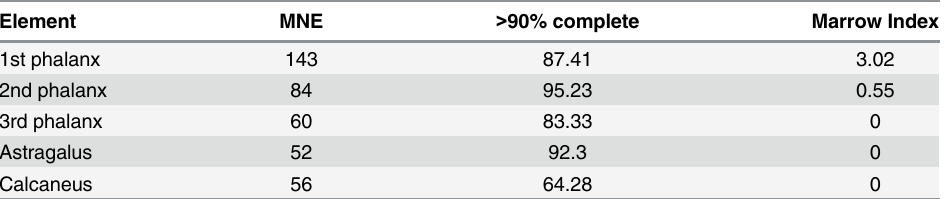
Table 4. MNE, element completeness and marrow index for gazelle foot bones with small but varying amounts of bone marrow. Bones are considered complete if more than 90% of the bone is present. Marrow index values from Bar-Oz and Munro